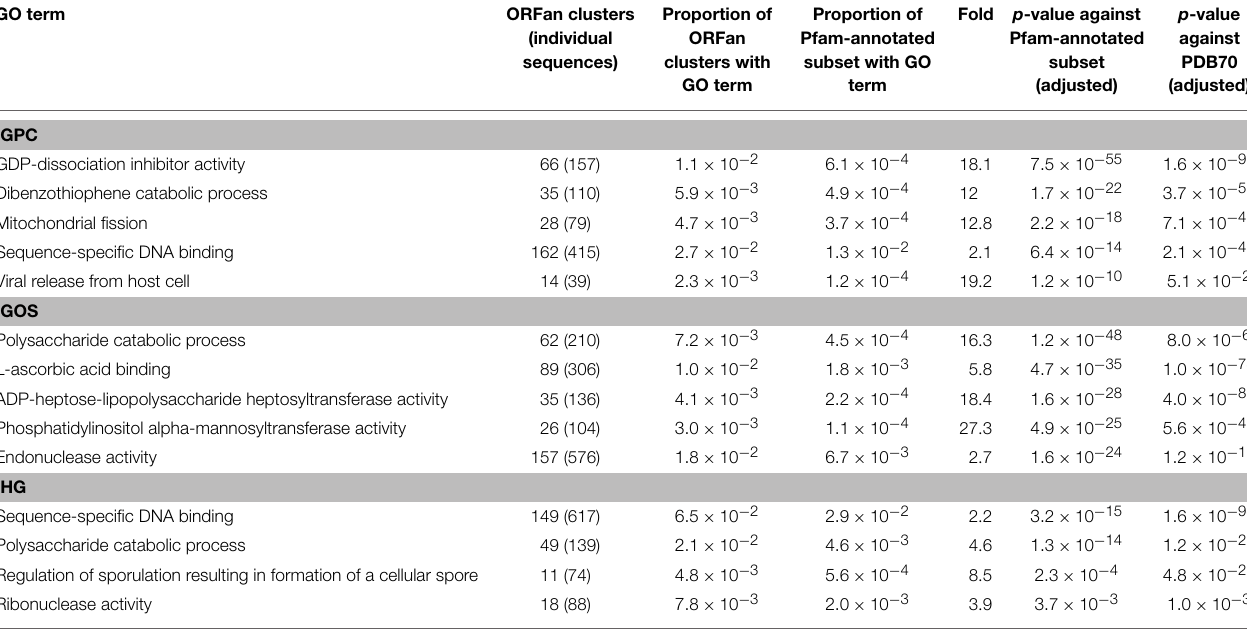
TABLE 3 | Top five significantly enriched GO terms among ORFans in each metagenome relative to non-ORFans and the PDB. GO